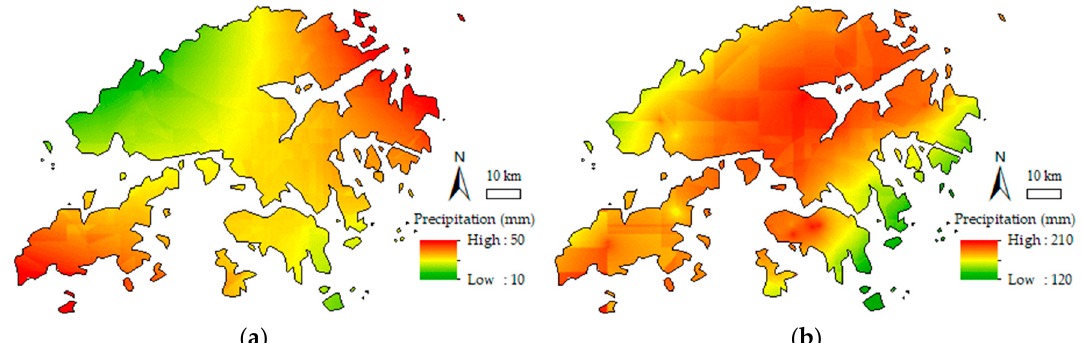
Figure 11. Precipitation distribution during the selected period. ( a ) Accumulated precipitation at 14:00 to 20:00 on August 22, 2017; ( b ) Accumulated precipitation at 03:00 to 14:00 23rd August 2017.